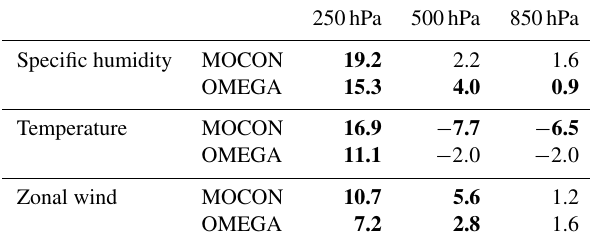
Table 2. Relative difference as percentage (with respect to the NCP configuration) in the number of times the ERA5 HRES reanalysis lies inside the range of the ensemble at lead time 48h for specific humidity, temperature and zonal wind. Values that are significant at the 95% confidence interval are highlighted in